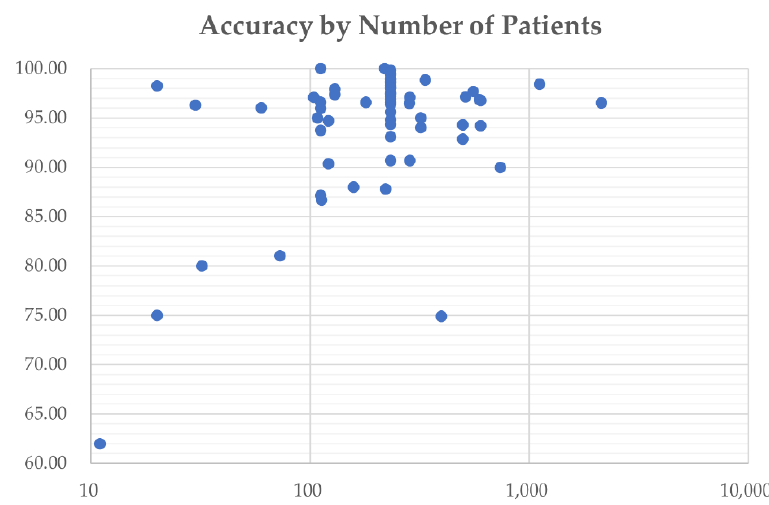
Figure 9. Classification accuracy by number of patients.